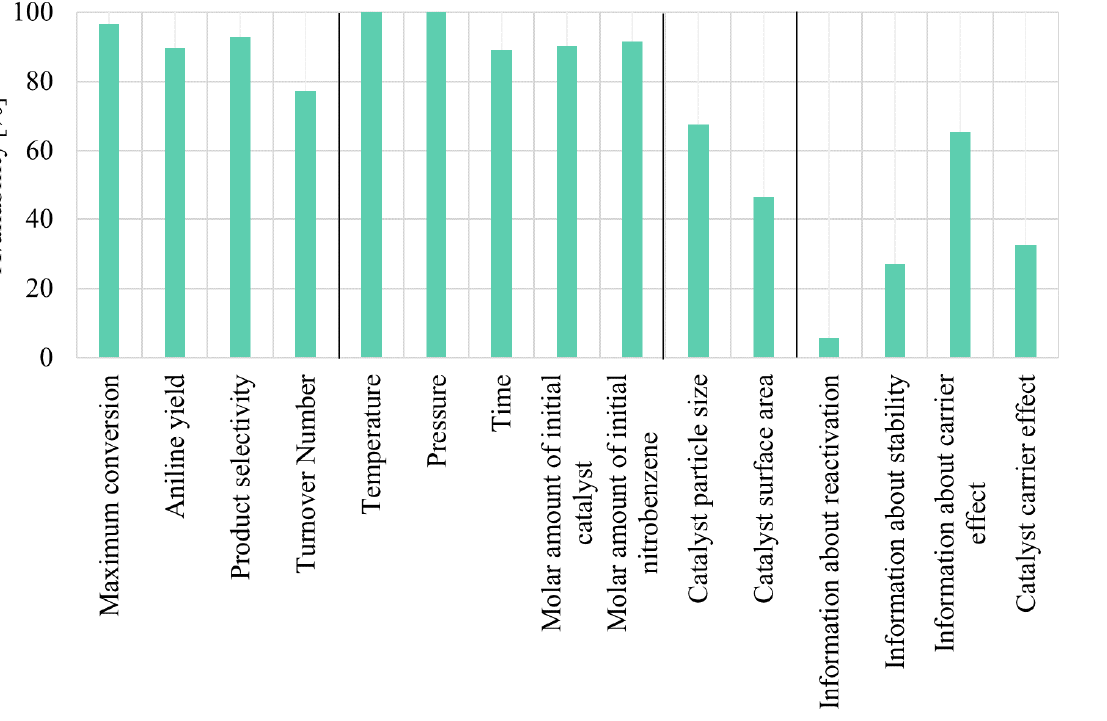
Figure 8. Availability of catalyst performance data on a box and whisker chart: maximum conver- sion, aniline yield, and selectivity data in percentage ( left ), TON [ – ] ( right ). On each box plot, the central black line indicates the median, and the solid part of the column shows the first quartile, and the striped part shows the third quartile. The conversion and yield values range from 1 – 100%, but the selectivity ranges from 32 – 100%. From the graph, it can be seen that the studied hydrogenation catalysts operate with high selectivity. An important point is that the range of the conversion results be- tween Q1 and Q3 is relatively large. However, selectivity has a Q1 – Q3 range between 92%